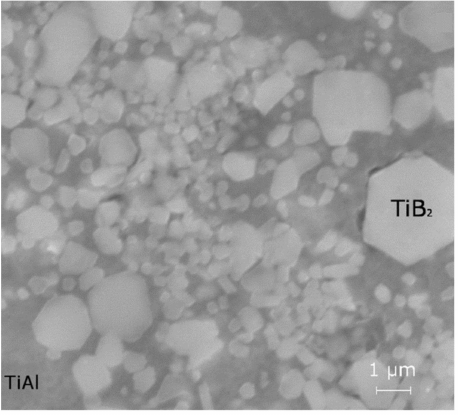
Figure 1. The microstructure of the master alloy [22]